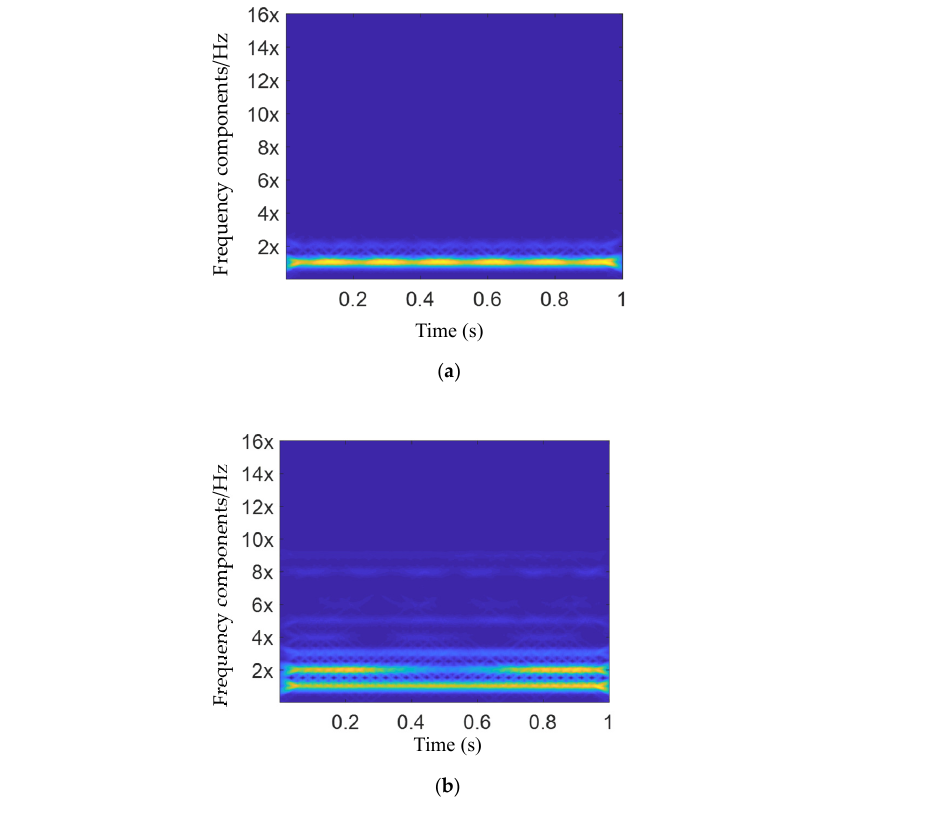
Figure 23. The GLCT for rubbing fault signals. ( a ) Slight rubbing ( b ) Serious rubbing.